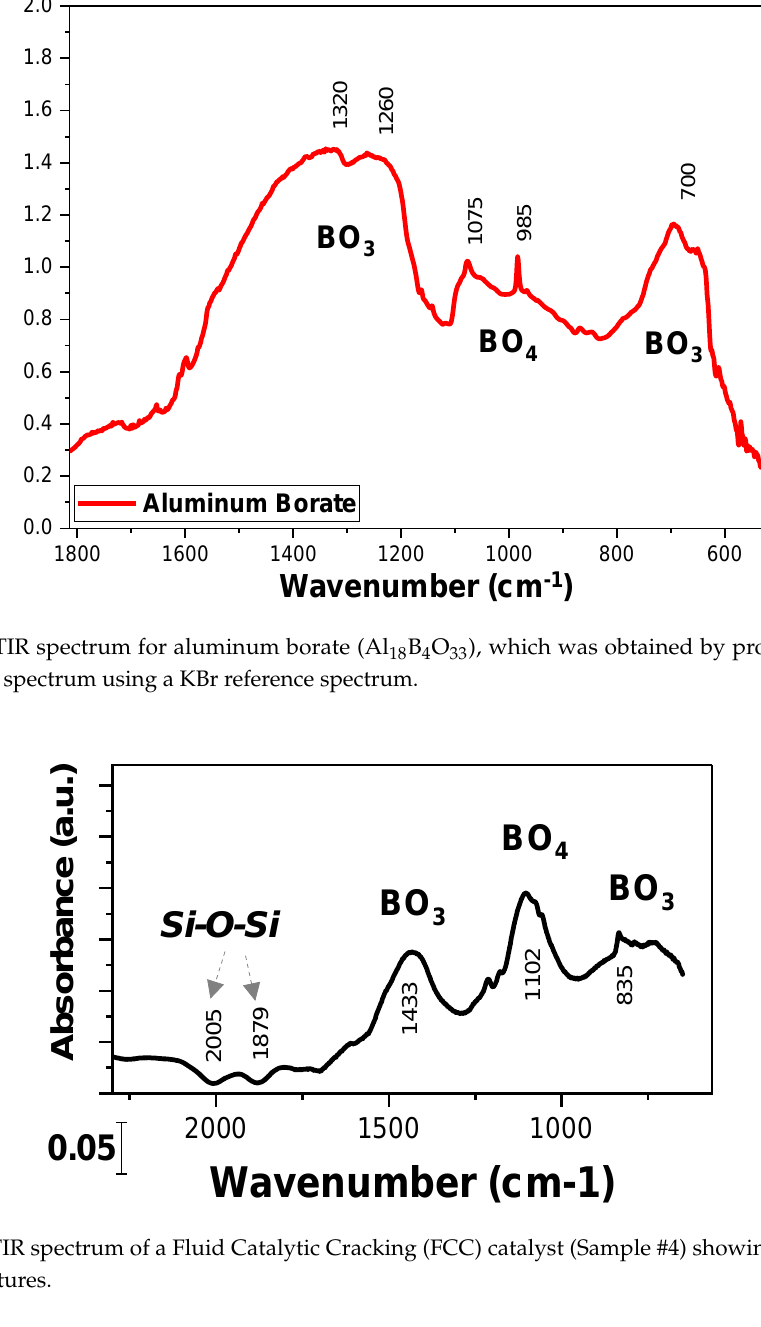
Figure 3. FTIR spectrum of a Fluid Catalytic Cracking (FCC) catalyst (Sample #4) showing BO 3 , BO 4 borate structures.